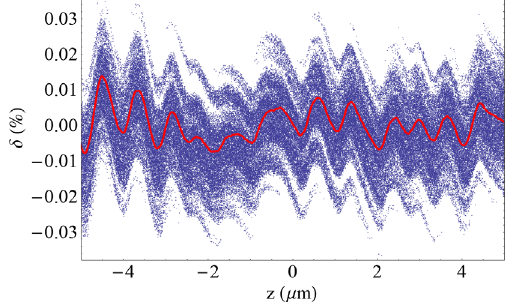
FIG. 3. Longitudinal phase space of the beam core at the entrance of DL1. The red curve is the slice centroid energy. The apparent ∼ 1 μ m energy modulation is the result of LSC during acceleration and transport following the second bunch compres- sor, placed about 700 m upstream of DL1.